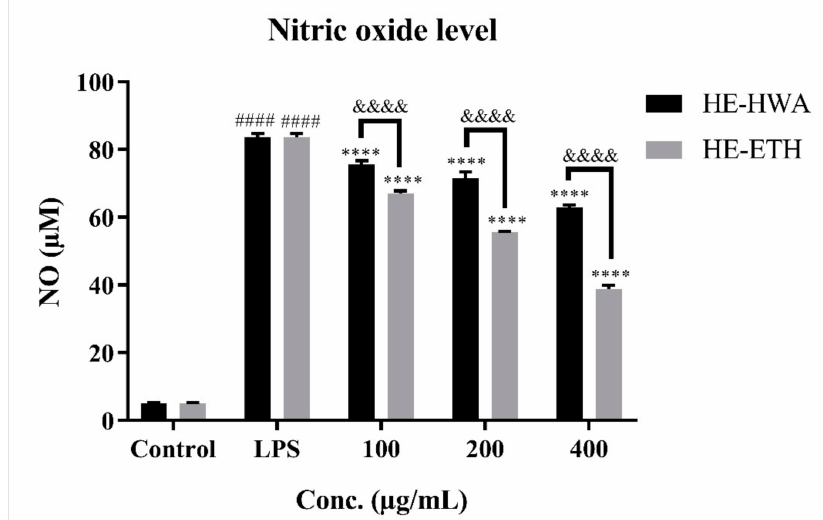
Figure 3. Inhibitory e ff ects of hot water (HE-HWE) and ethanolic (HE-ETH) extracts on LPS-induced NO production in BV-2 microglial cells. All values presented correspond to mean ± SD of three independent experiments ( n = 3). Values of #### p < 0.0001 compared with control and **** p < 0.0001 compared with lipopolysaccharide (LPS)-treated group, were considered as statistically significant. Values of &&&& p < 0.0001 between the treatment groups were considered as statistically